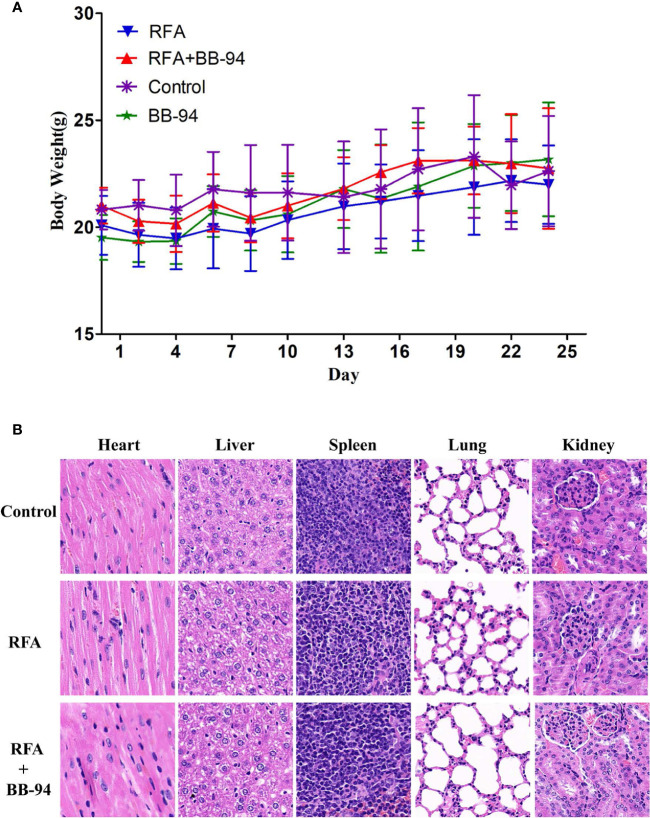
Toxicity and safety evaluation. (A) Changes in mice weight after treatment. During the period of follow-up, there were no obvious difference in the bodyweight change after treatment in the four experimental groups (P > 0.05). (B) Microscopy pathological HE staining demonstrated there was no obvious histopathological changes in heart, liver, spleen, lung, kidney in both RFA and RFA+BB-94 groups.